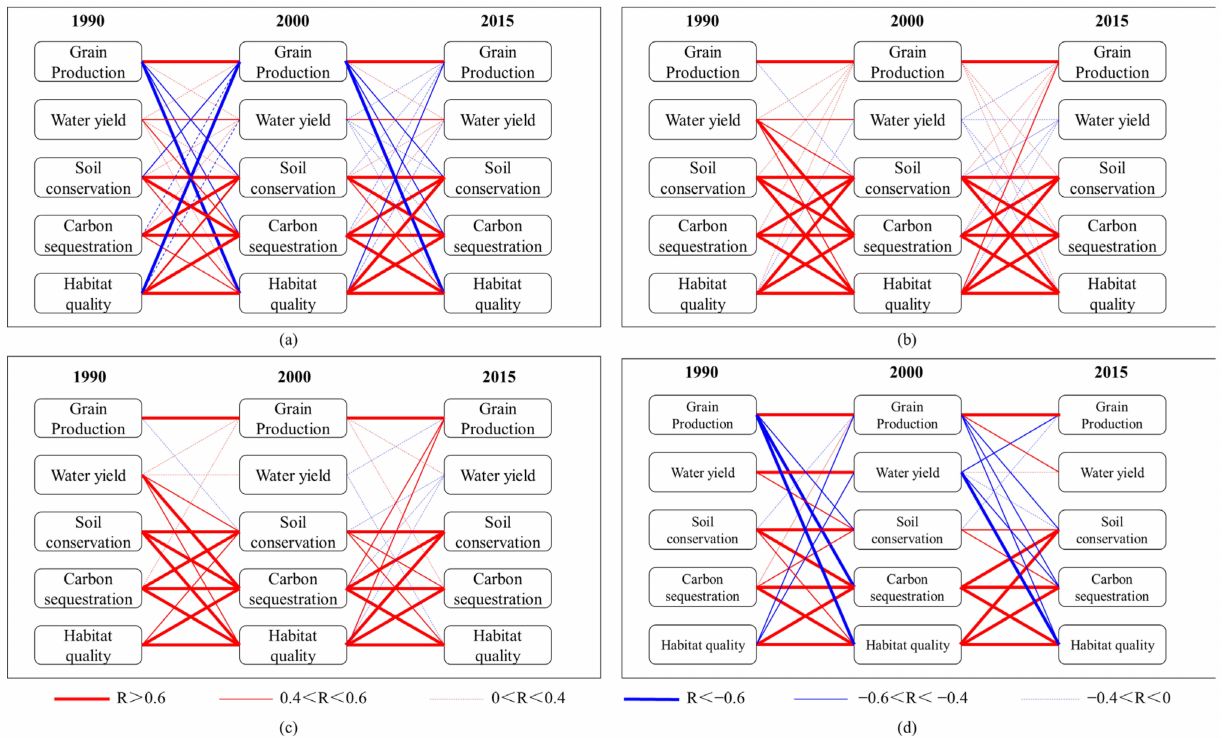
Figure 4. The inter-annual trade-offs/synergies among ecosystem services across spatial scales in the Pearl River